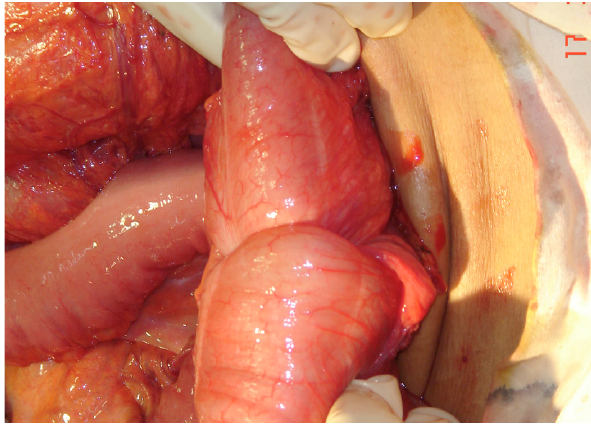
Figure 2: Colocolic intussusception showing intussusceptum and intussuscepien during operative